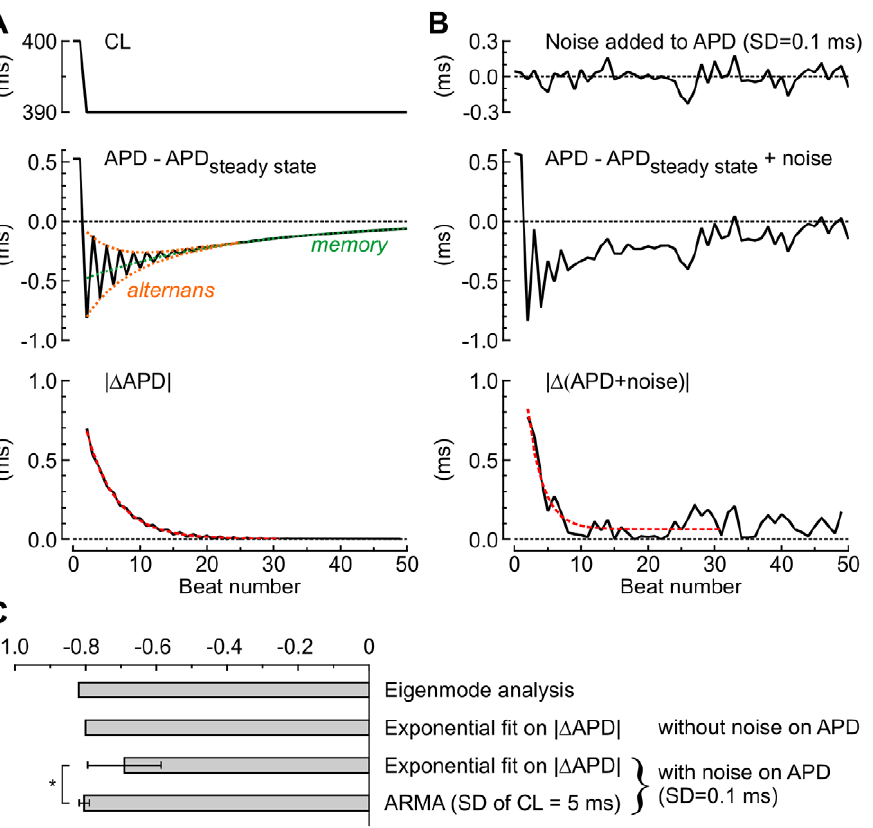
Figure 8. Superiority of ARMA model identification during stochastic pacing vs. a time domain analysis after a step change in BCL. A : Response of the Ca 2 + -driven model with positive Ca 2 + to APD coupling to a step decrease of BCL from 400 to 390 ms. Top : Pacing protocol. Middle : Difference between APD and steady state APD at BCL=390 ms, showing transient decaying alternans followed by an exponential convergence to steady state. Orange and green dotted lines denote the components determined by the alternans and memory eigenmodes, respectively. Bottom : Absolute value of the APD difference series, reflecting the decay of the alternans eigenmode. The red curve illustrates the best fit with an exponential function, yielding l alt = 2 0.800. B : Same data and analysis as in A , but with a Gaussian noise added on APD (SD=0.1 ms, top panel ), yielding l alt =0.643. C : Comparison of l alt obtained with different methods, with eigenmode analysis serving as control. In the presence of noise added to APD, stochastic pacing and ARMA model identification was superior to the time domain analysis with exponential fitting (n=37; * p , 0.05, two-tailed Fisher-Snedecor’s F -test on variance).